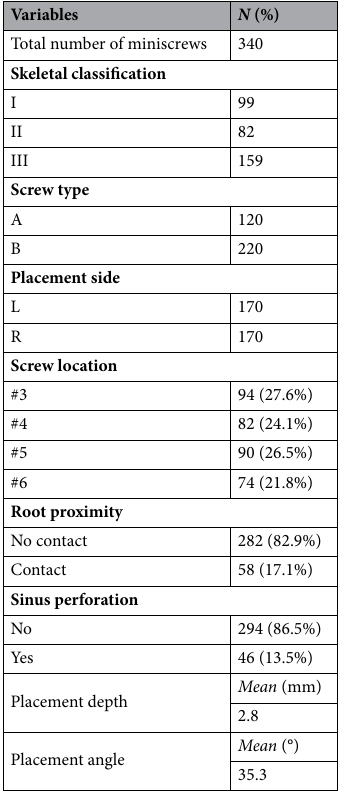
Table 1. Sample distribution according to variables. L left, R right; #3 Canine, #4 1st premolar, #5 2nd premolar, #6 1st